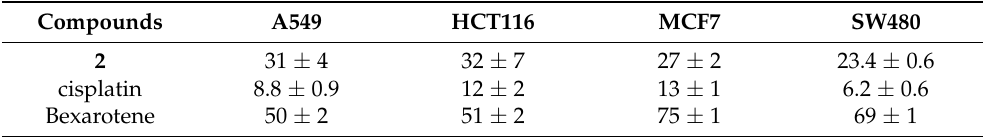
Table 1. The 50% inhibitory concentrations of complex 2 , bexarotene and cisplatin. Values are means ± SDs obtained by the MTT ‐ assay (exposure time: 72 h).